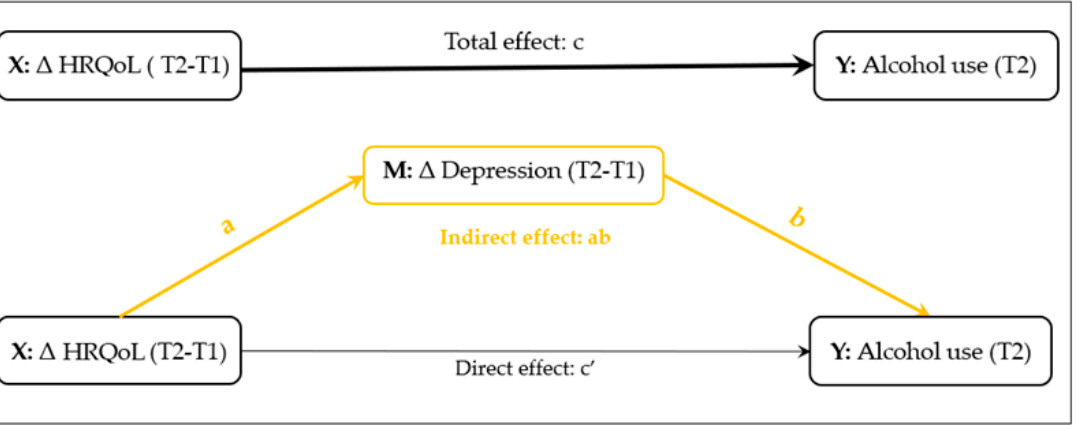
Figure 1. Conceptual diagram of the mediation model of change in depressive symptoms ( ∆ T2-T1) on the relationship between change in health-related quality of life (HRQoL) ( ∆ T2-T1) and alcohol use.